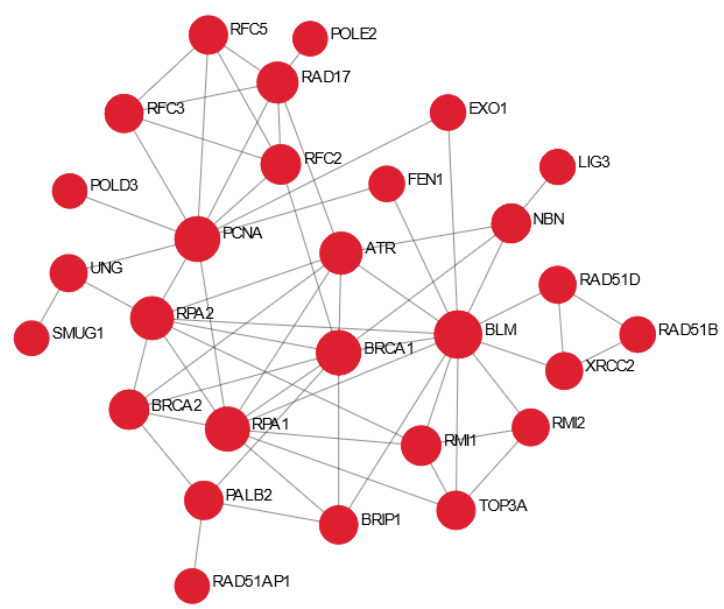
Figure 4. Network indicating DJK-5 enhancement of DNA repair functions in biofilm infected skin. A zero-order protein–protein interaction network of DE genes comparing DJK-5 treated vs. untreated MRSA biofilm skin infection using NetworkAnalyst. Red nodes denote upregulation.